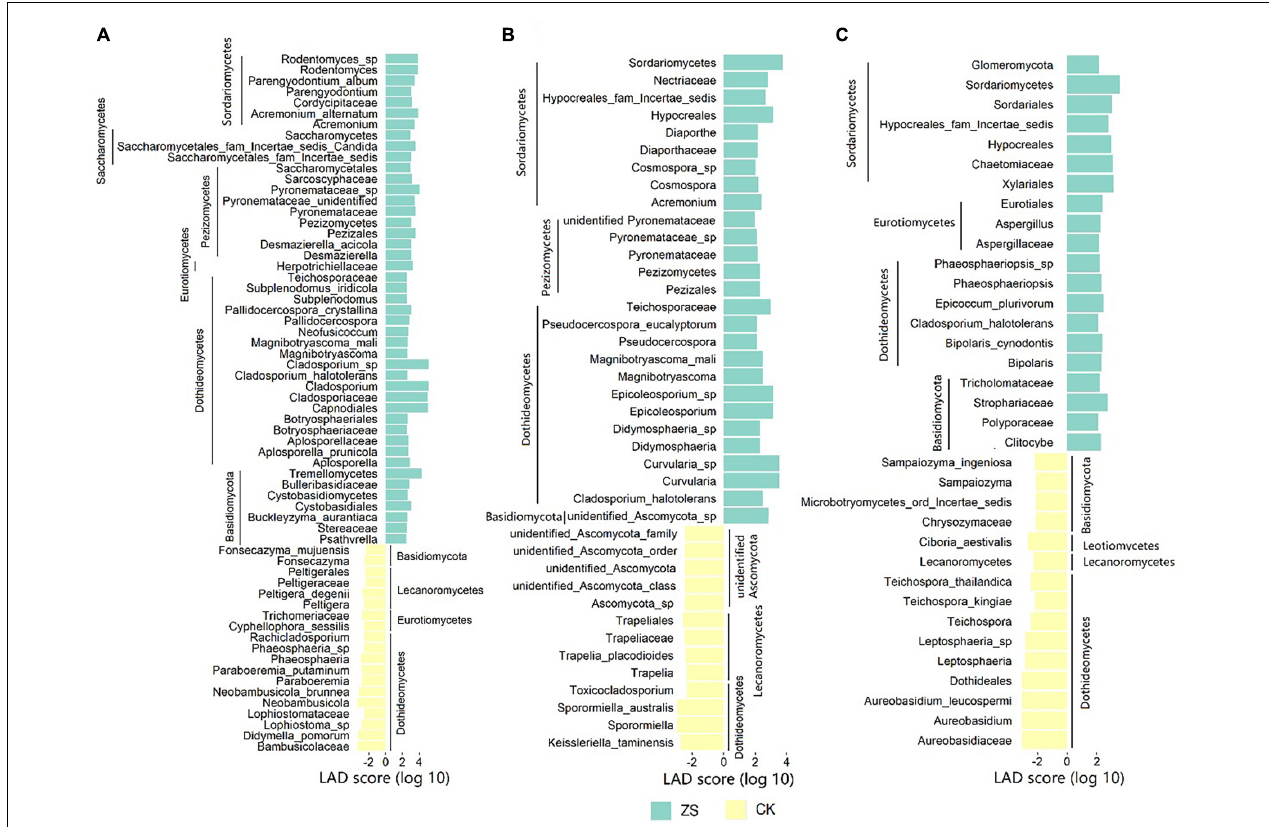
FIGURE 3 | Taxonomic biomarker of the endophytic fungal community in ordinary (CK) and nornicotine-enriched (ZS) tobacco leaves at lower (A) , center (B) , and upper (C) plant sections revealed by linear discriminant analysis effect size